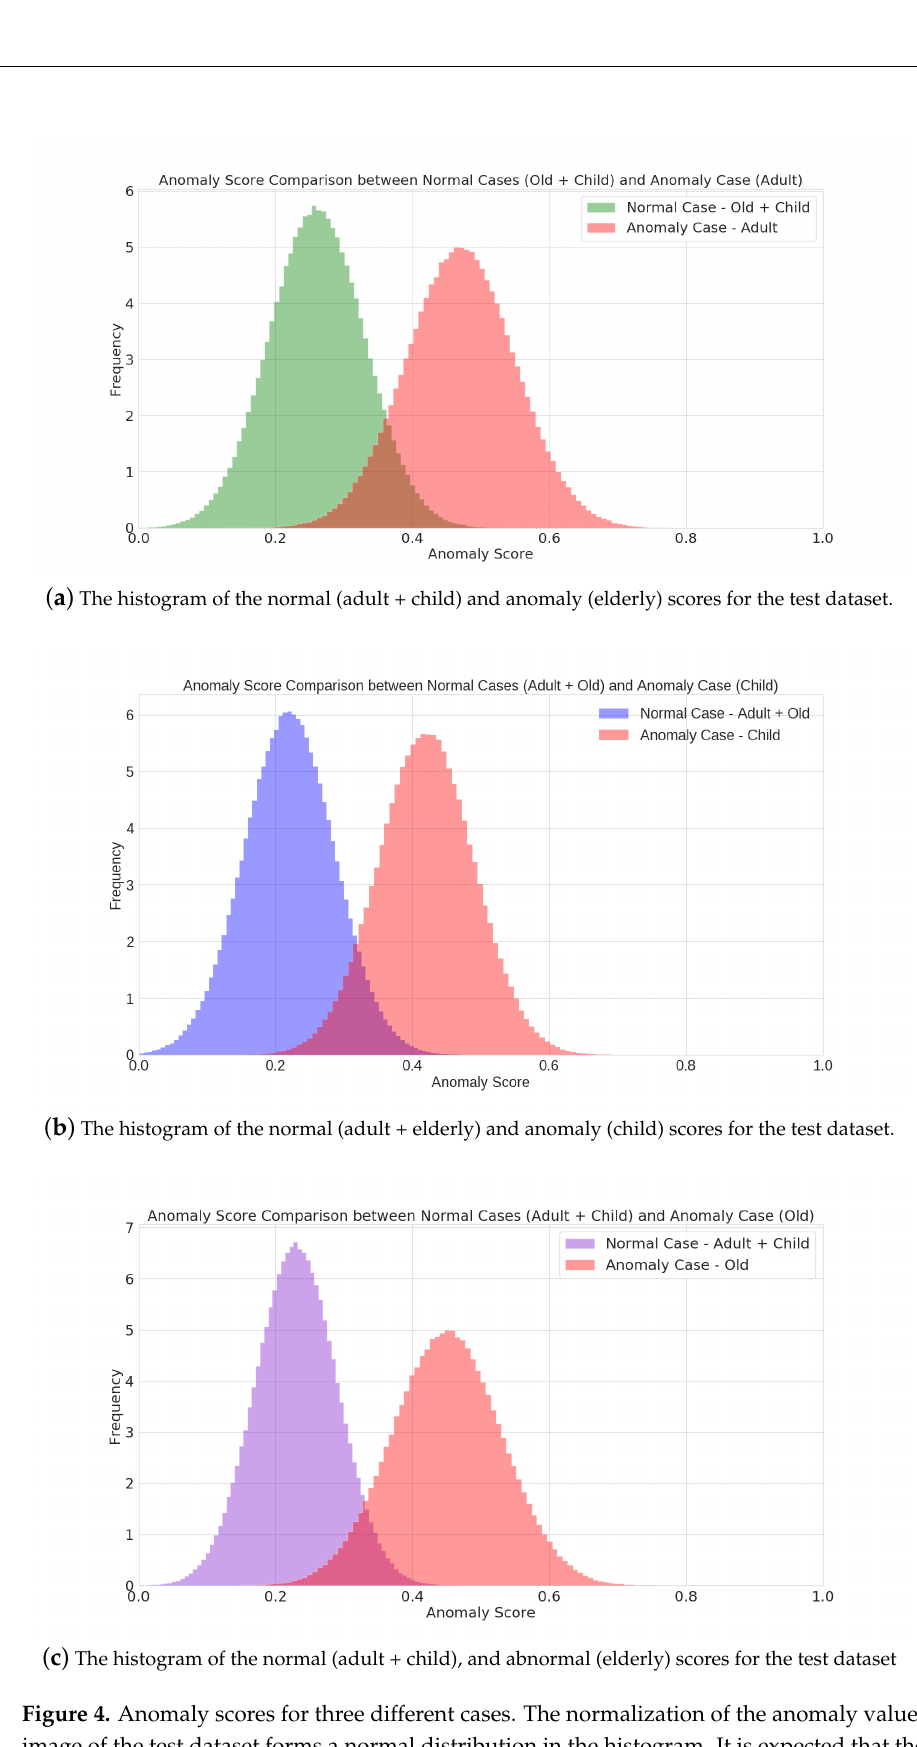
Figure 4. Anomaly scores for three different cases. The normalization of the anomaly value for each image of the test dataset forms a normal distribution in the histogram. It is expected that the normal inference images will form a normal distribution closer to zero, and the abnormal inference images will form a normal distribution closer to